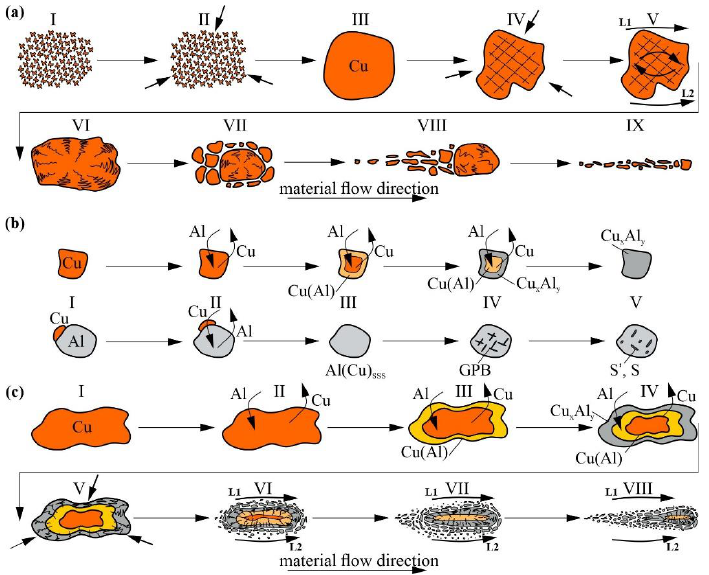
Figure 16. Schematic diagrams showing the effects of thermomechanical compaction ( a ), reaction- diffusion interaction ( b ) and combined mechanical-diffusion interaction ( c ) during FSP on AA5056 + Cu systems.